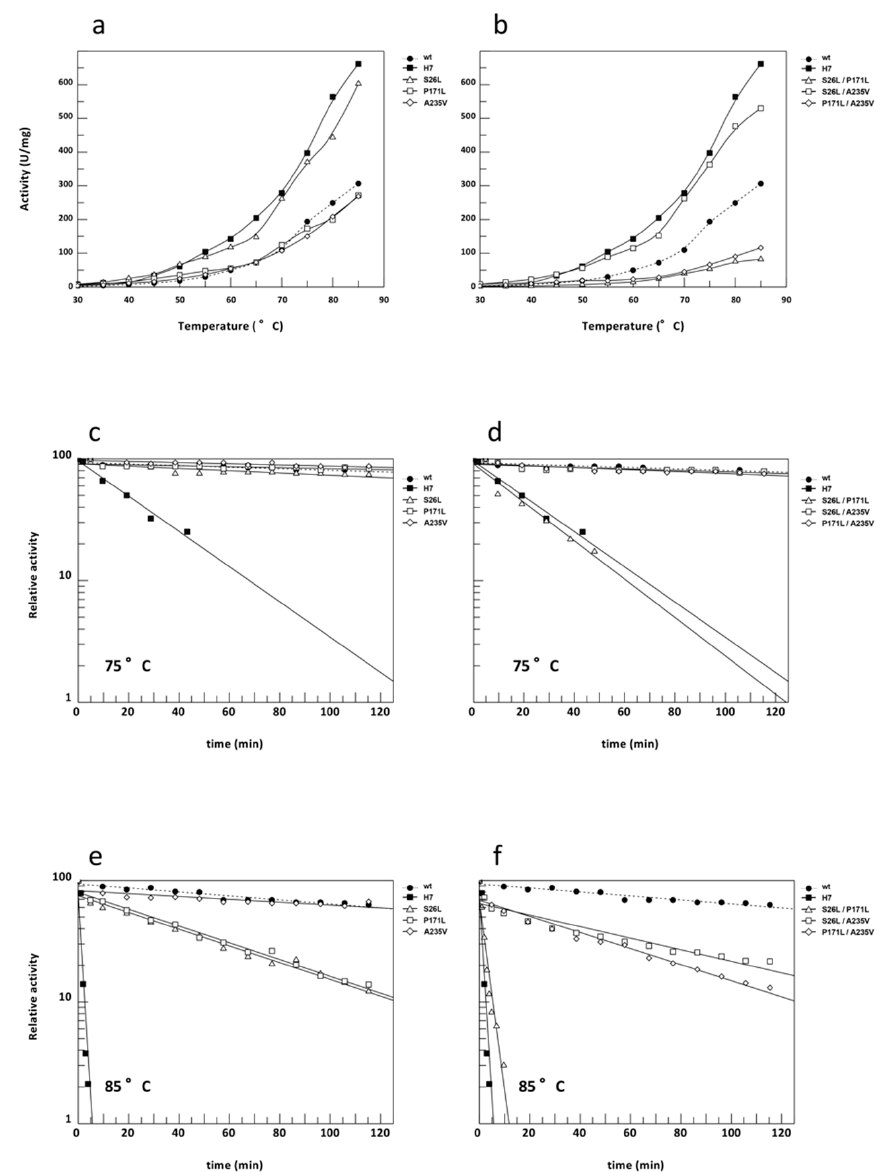
Figure 2. Thermal activity and stability of Ss β -Gly H7 and relative single and double mutants. The dependence on temperature of the wild type is compared with the H7 mutant; single ( a ) and double mutants ( b ). Similarly, the residual activity at 75 °C and 85 °C of the wild type, in comparison with H7 mutant, single ( c , e ) and double mutants ( d , f ), is reported. Ss β -Gly (closed circles on dotted line); Ss β -Gly H7 (closed squares); L26 (open triangles); L171 (open squares); V235 (open diamonds); L26/L171 (open triangles); L26/V235 (open squares); L171/V235 (open diamonds).